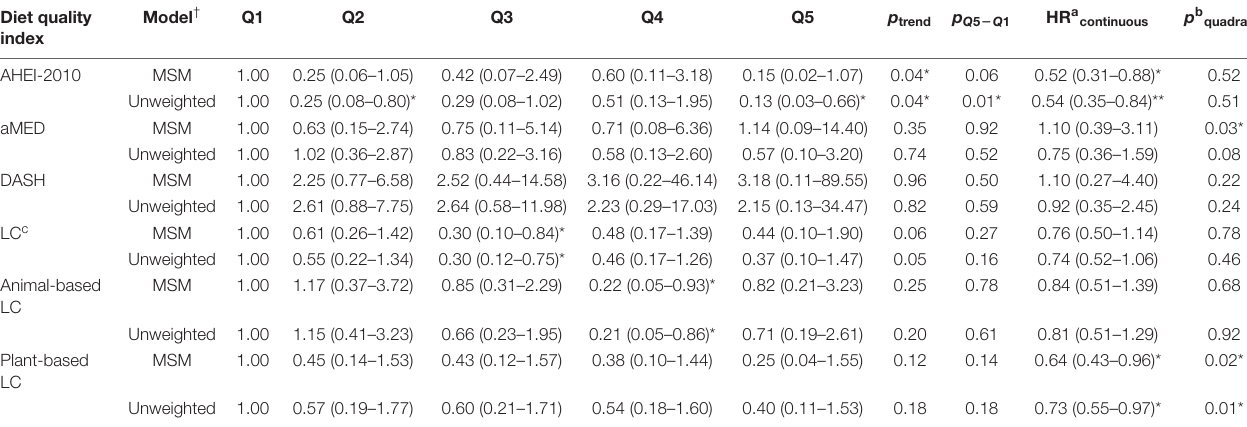
TABLE 4 | HRs † and 95% CIs for cancer-specific mortality from both marginal structural models and unweighted models across each dietary index. Diet quality